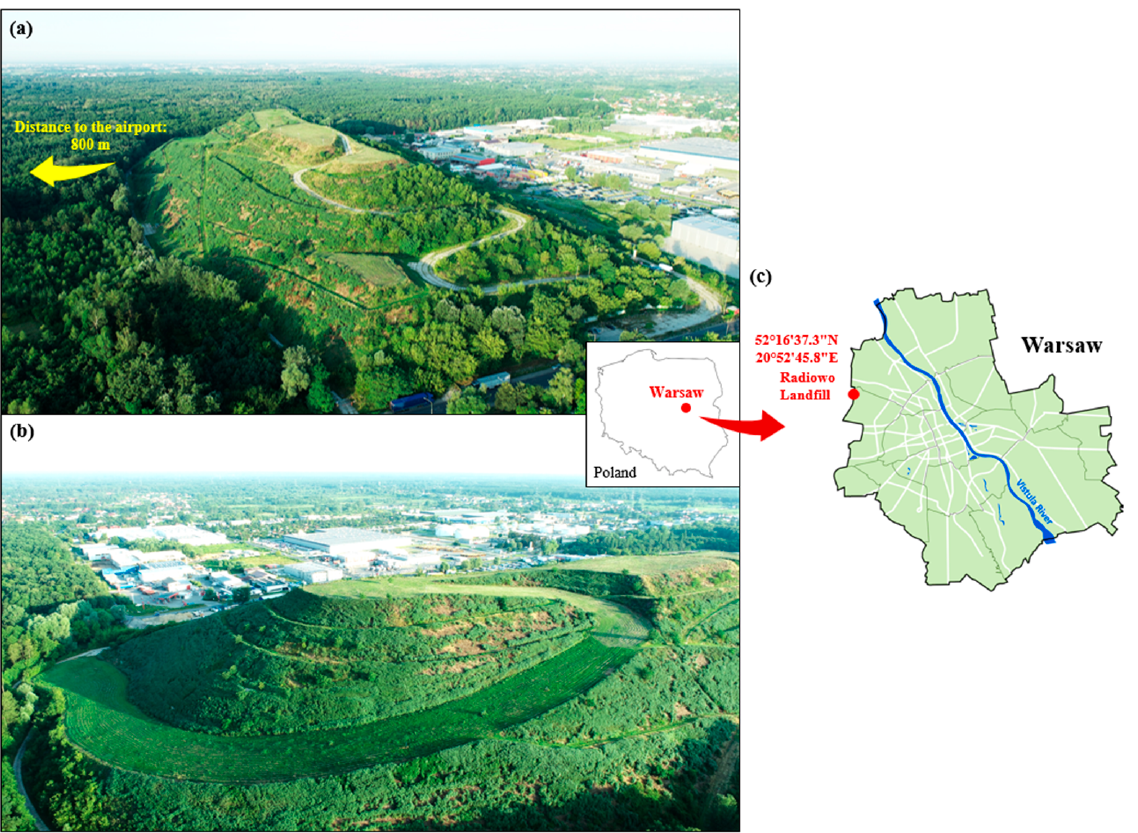
Figure 1. Location of the Radiowo landfill in Warsaw: ( a ) view from the access road (northeast slope), ( b ) view from the ski run (southeast slope), and ( c ) location of the landfill within the administrative borders of Warsaw.